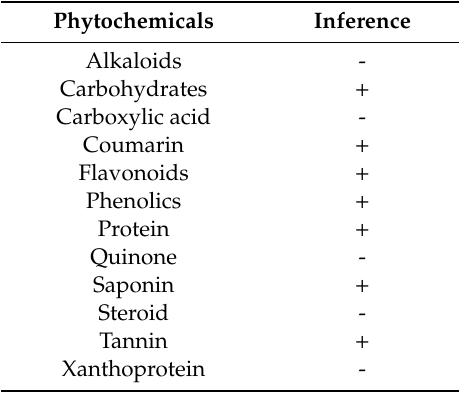
Table 3. Phytochemical composition of EF – LSE.